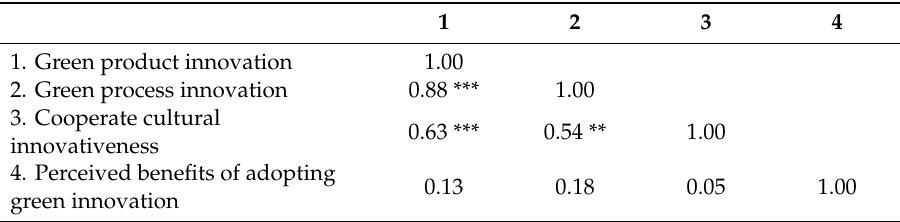
Table 4. Correlations of the